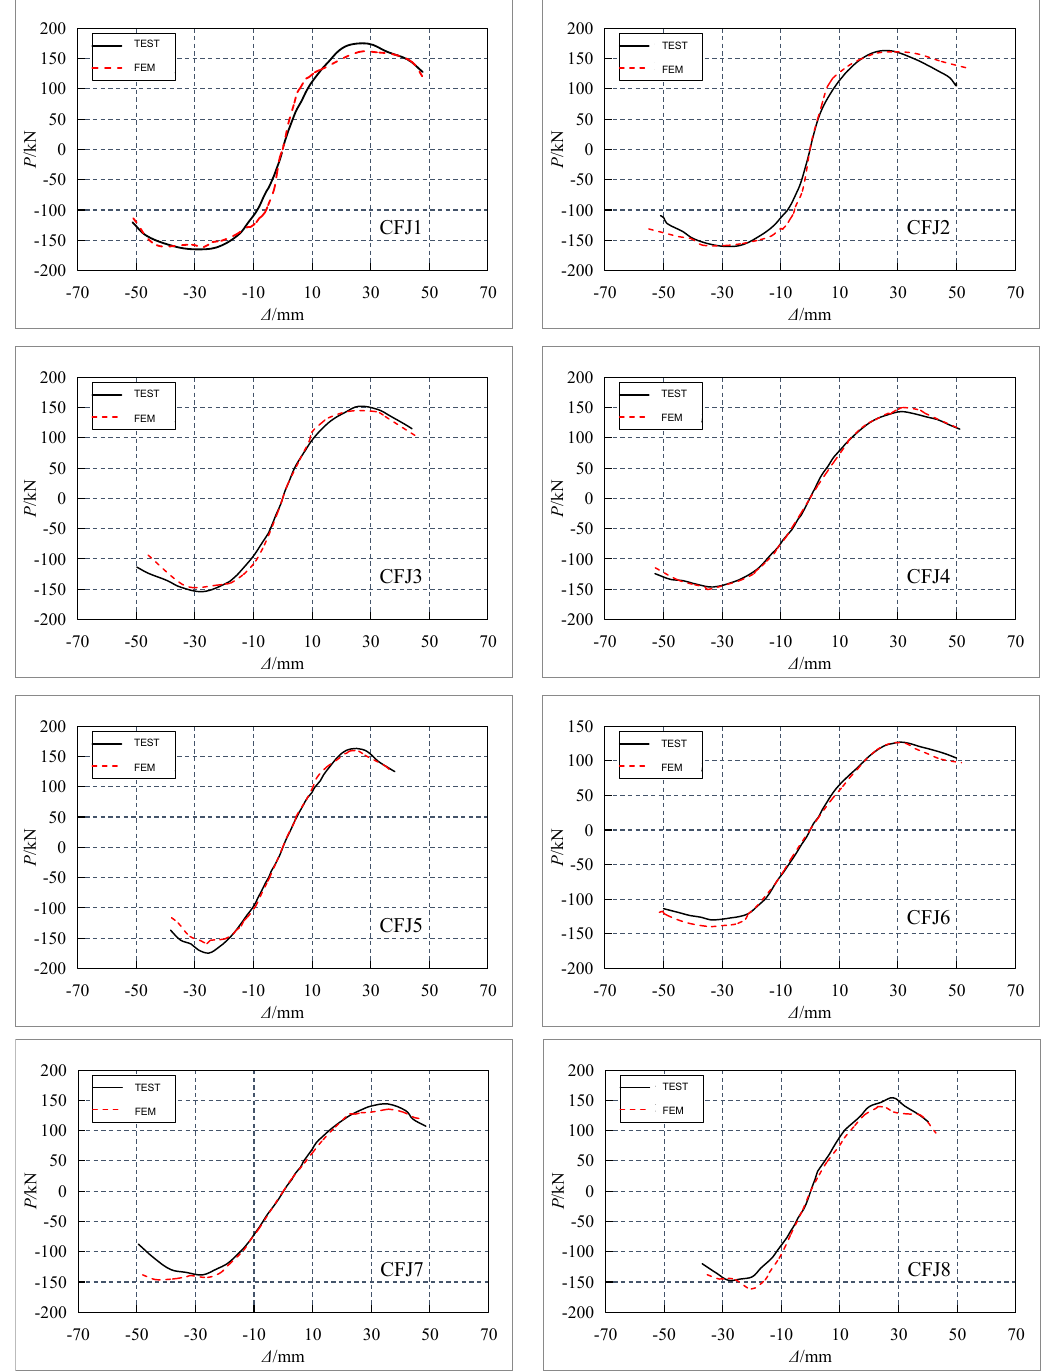
Figure 14. Comparison of test and simulation results of skeleton curves of composite joints.